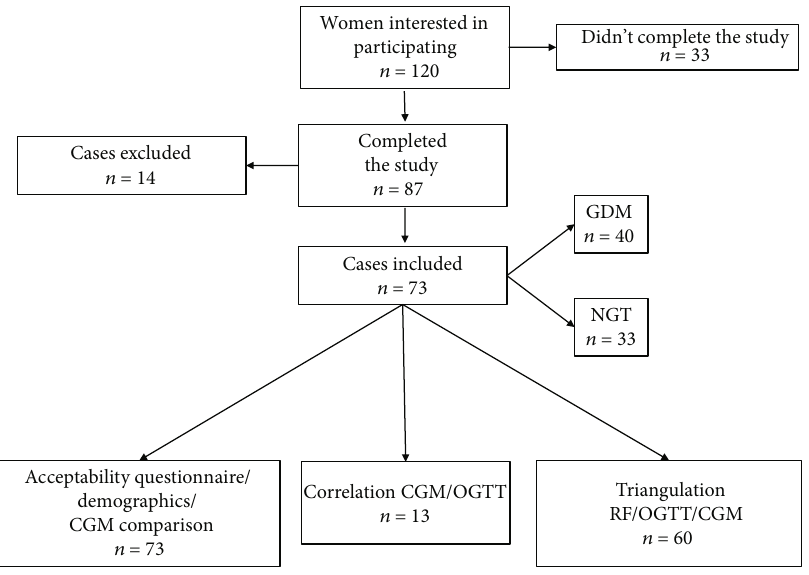
Figure 1: Consort